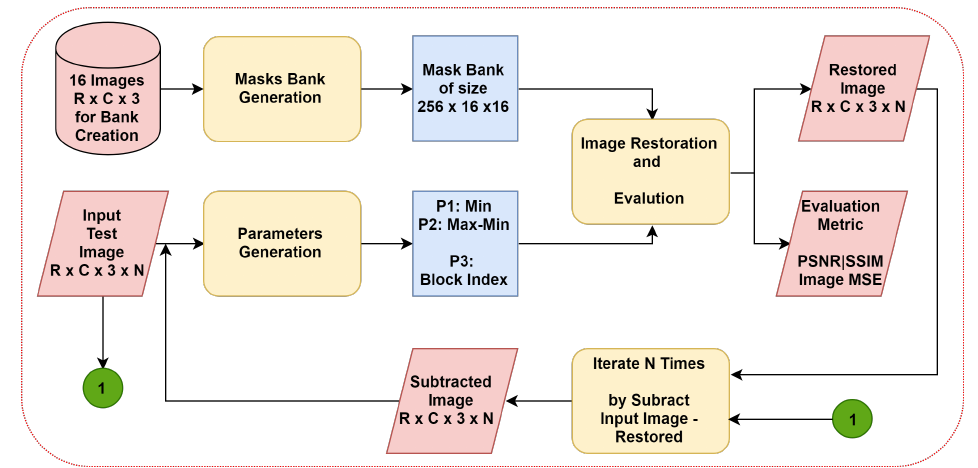
Figure 2. The diagram of the overall Multi-Chimera Transform.